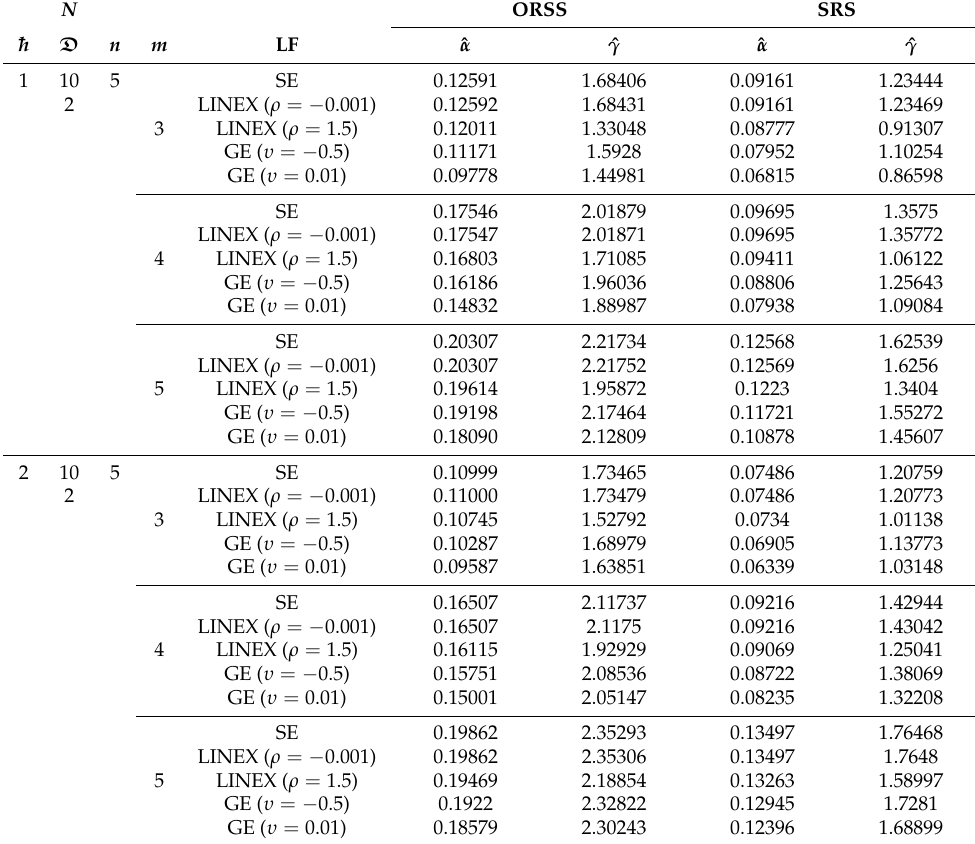
Table 6. BEs of α and γ based on SRSs and ORSSs (one-cycle and two-cycle) presented in Table